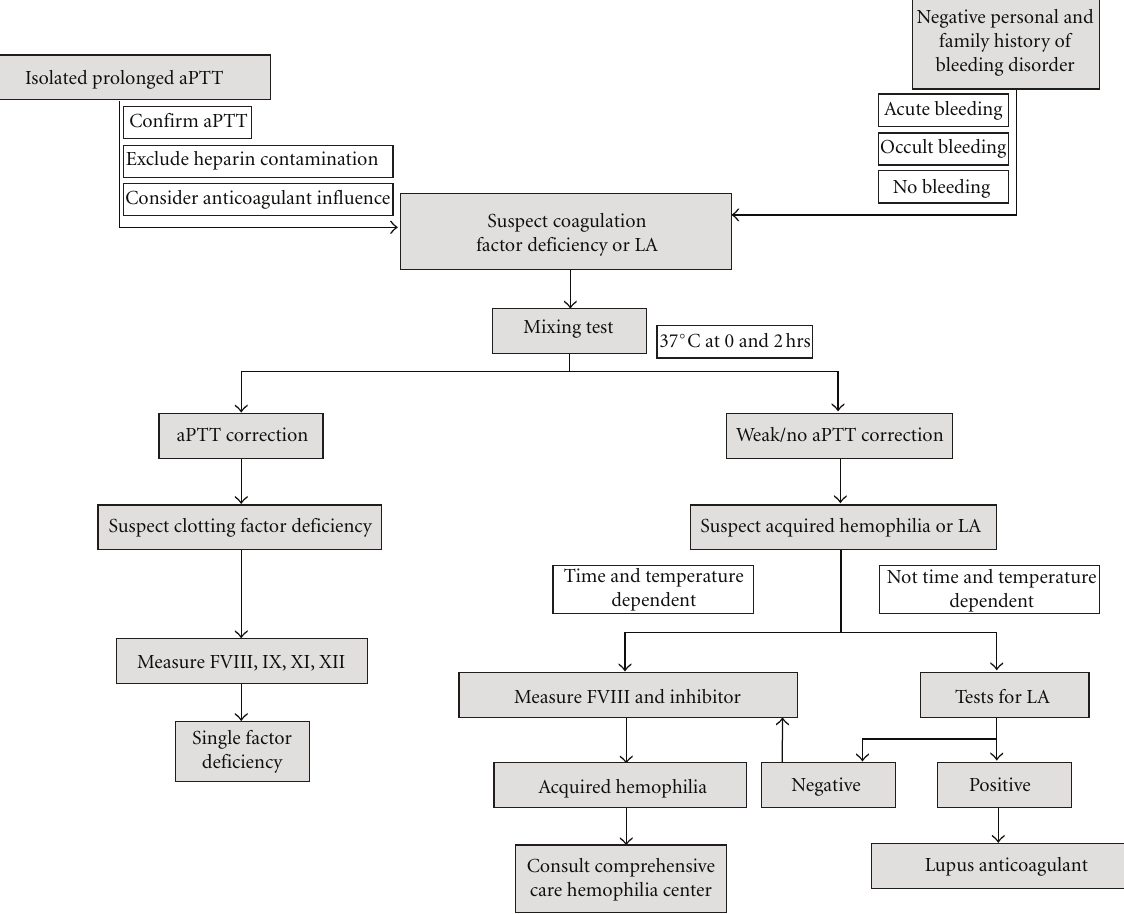
Figure 1: Algorithm to guide the management of patients with suspected acquired hemophilia. AH, acquired hemophilia; LA, lupus anticoagulant; F, coagulation factor; aPTT, activated partial thromboplastin time. Reprinted with permission from Collins et al.